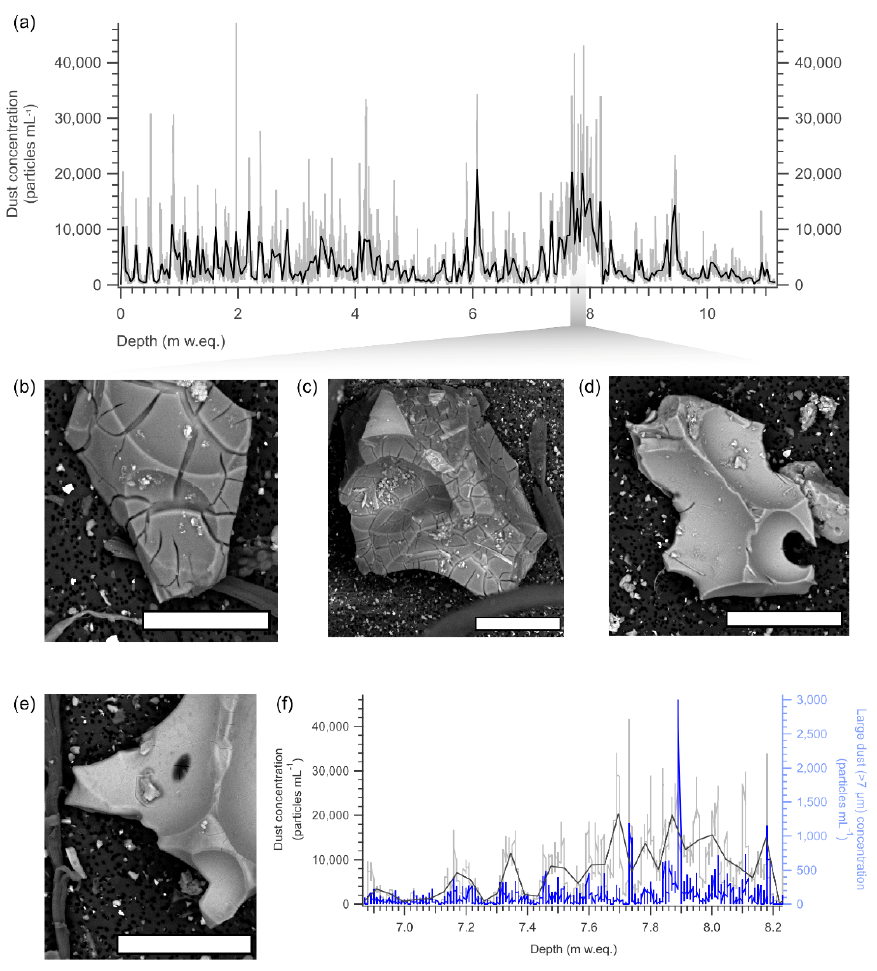
Figure 12. Identification of an age tie point; ( a ) full dust (>1 µ m) concentration profile derived from the Young Island ice core using CFA (light grey) and the derived 100-point average (black); ( b – e ) micrographs of cryptotephra shards identified in the ice sampled between 7.7 and 7.95 m w.eq. depth, scale bar in bottom right of each frame represents 50 μm; ( f ) detailed view of total dust particle concentration using the colour code of panel ( a ) and coarse dust particle size fraction (blue) at 6.8–8.2 m w.eq. depth.